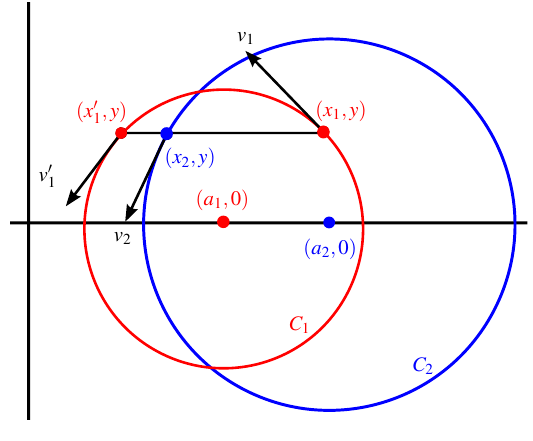
Figure 5: The vectors v 1 and v 2 are admissible with respect to ( x 1 , y ) and ( x 2 , y )